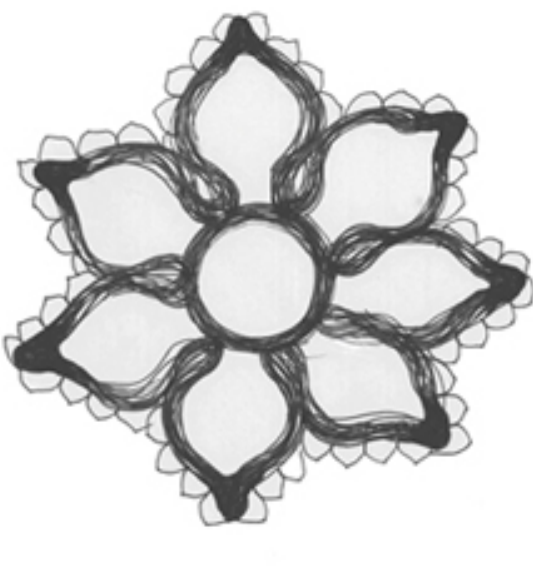
FIGURE 2. The structure of the life mission. This drawing is made by the same female tinnitus patient, and depicts the essence of her self as a flower of talents, with her life mission as the central core and the secondary talents as the petals; attached to these are tertiary talents and so forth. Two years after the therapeutic breakthrough that allowed her to formulate her life mission, her tinnitus seemed permanently healed and she is able to work again as an artist, more talented than before. The white flower has no dark petals (suppressed talents), illustrating that her ego has now been tuned to her life mission and her inner conflicts have lost their power to make her sick.